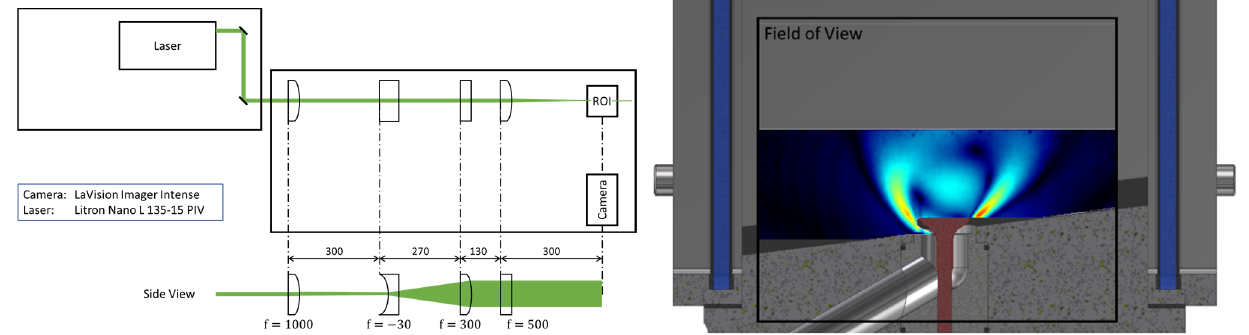
Figure 4. Optical setups of the PIV technique: Low-speed (@4 Hz) using Litron Nano L 135-15 PIV Nd:YAG laser ( left ), Fields of view of the flow around the valve: Approx. 120 mm × 100 mm for LS-PIV ( right ).